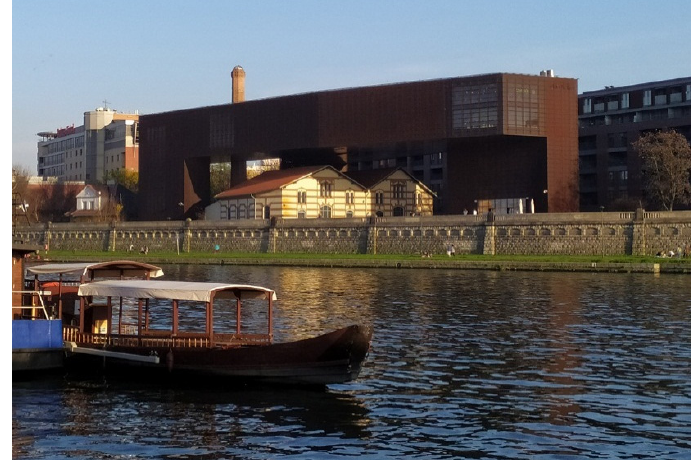
Figure 14. Centre of the Documentation of the Art of Tadeusz Kantor-Cricoteka, designed by Biuro